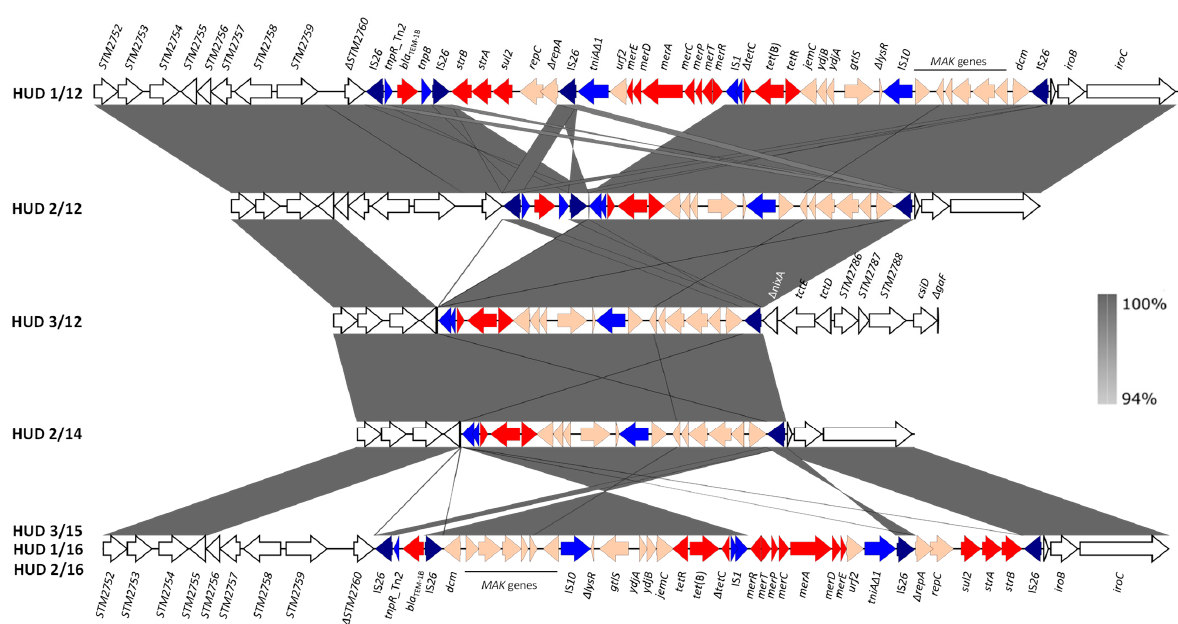
Figure 3. Genetic organization and comparisons of the chromosomal RR regions found in the monophasic S . Typhimurium ST34 isolates from a Spanish hospital. Coding regions are represented by arrows indicating the direction of transcription and colored according to their function: red, resistance; blue, DNA mobility, with IS 26 highlighted in darker blue; orange, other roles; white, flanking chromosomal ORFs named according to accession number NC_003197, which corresponds to the chromosome of S . Typhimurium LT2 [45]. The alignments were created with EasyFig BLASTn. The gray shading between regions reflects nucleotide sequence identities according to the scale in the right bar.